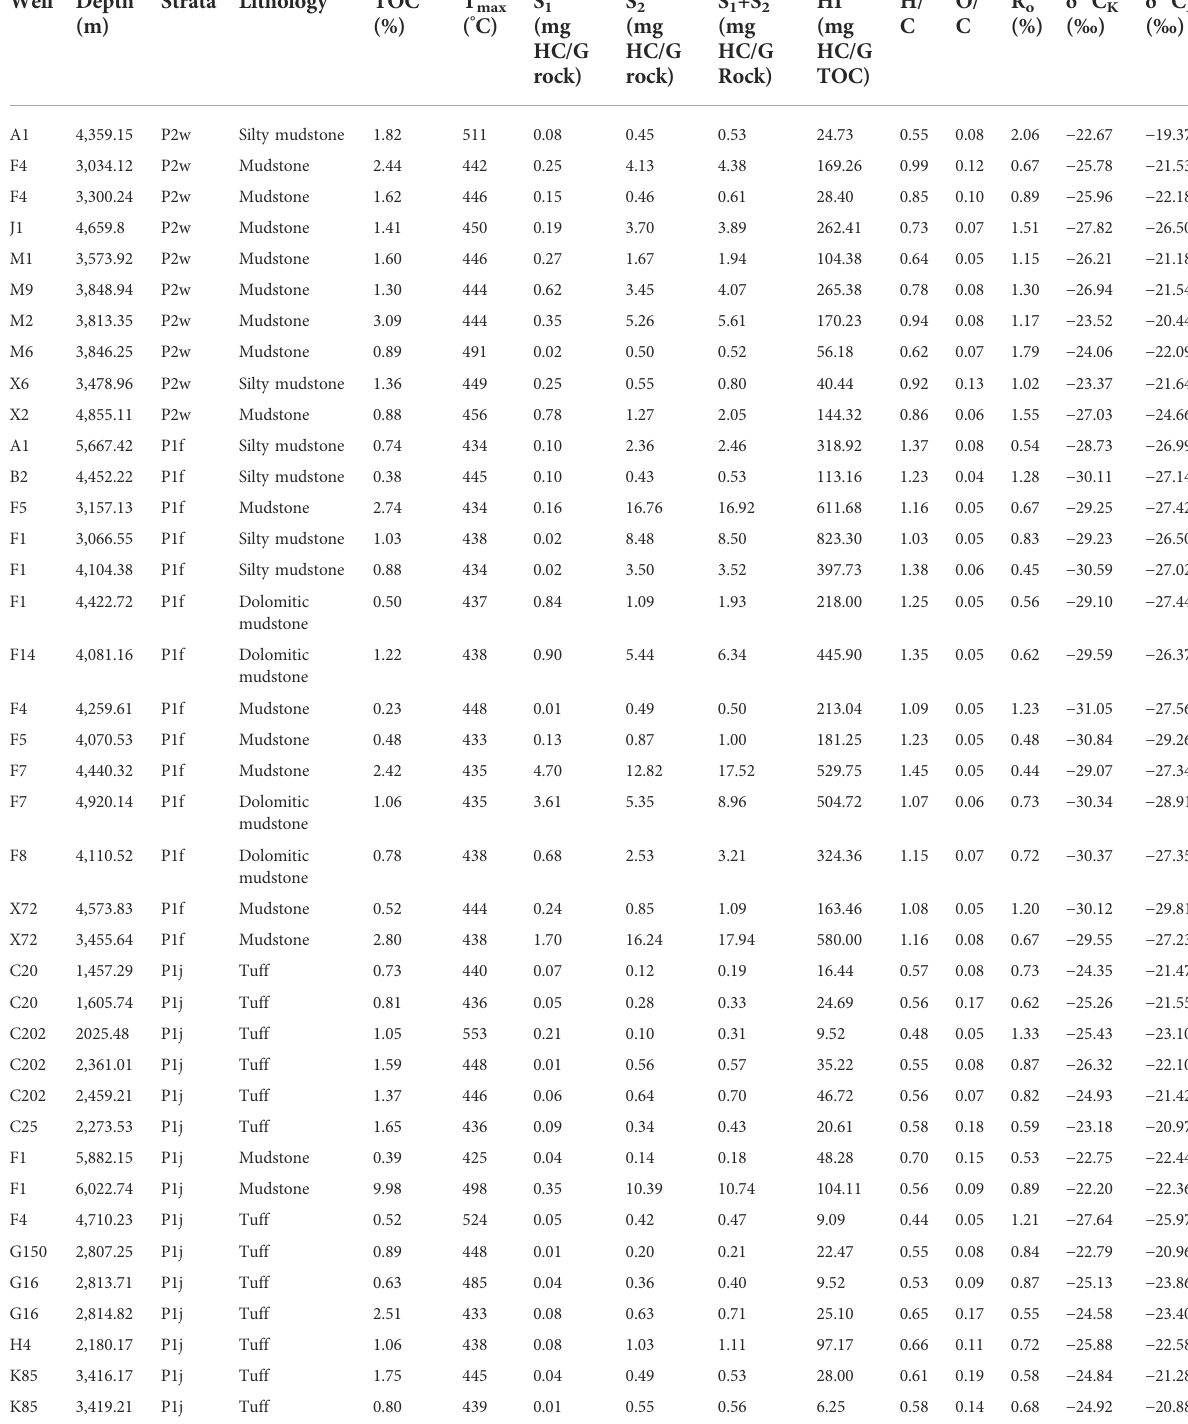
TABLE1Totalorganiccontent,Rock-Evalpyrolysis,vitrinitere fl ectance,kerogenelementandcarbonisotopicdatafromP 2 w,P 1 f,andP 1 jsourcerock samples in the western Junggar